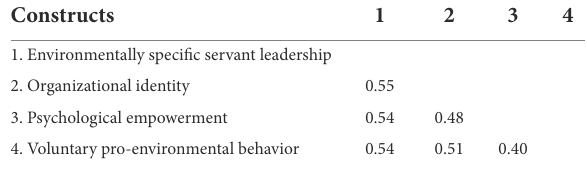
TABLE 2A Assessment of discriminant validity.